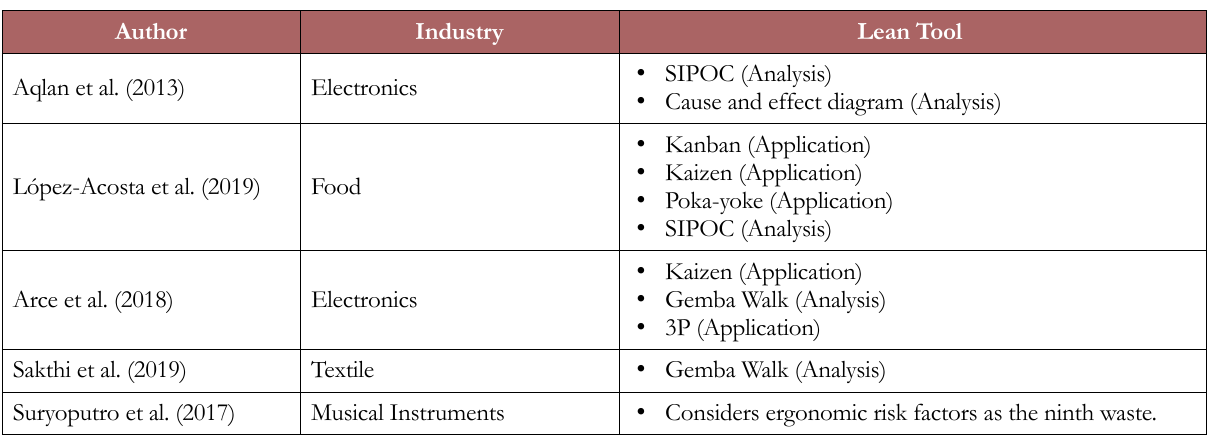
Table 5. Lean Manufacturing tools used in